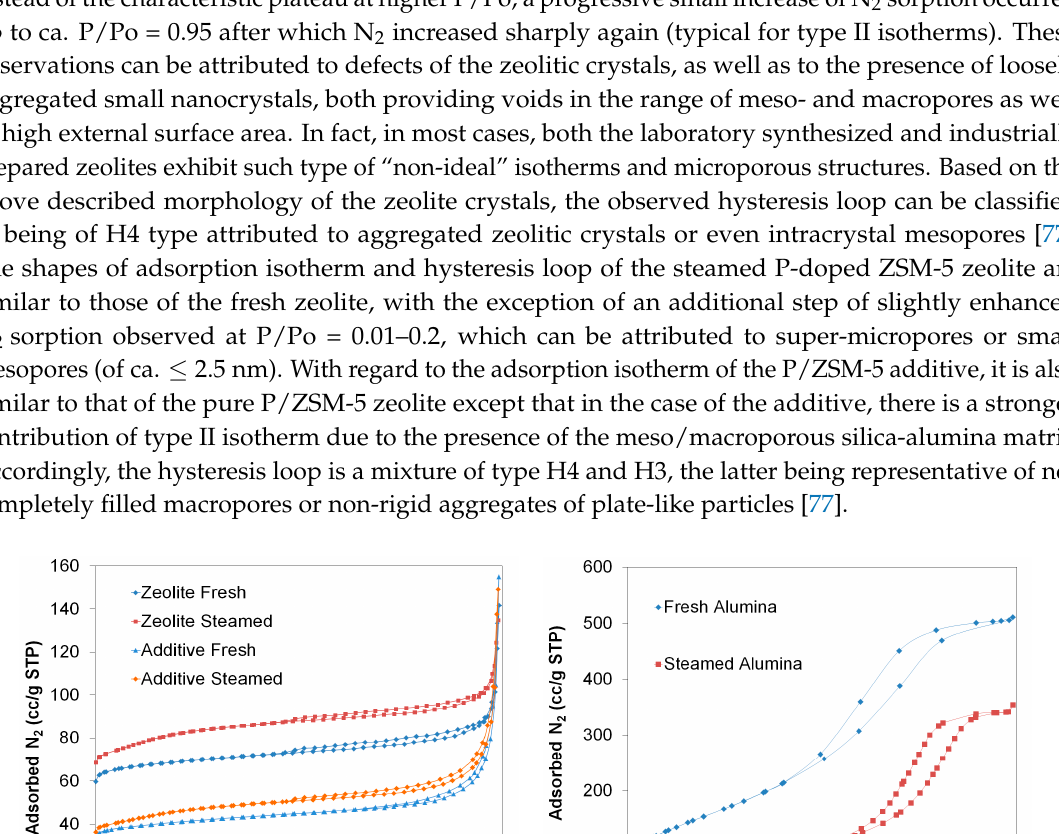
Table 2. Porosity characteristics of the fresh and steamed (1) , ZSM-5 zeolites, ZSM-5 additives, and